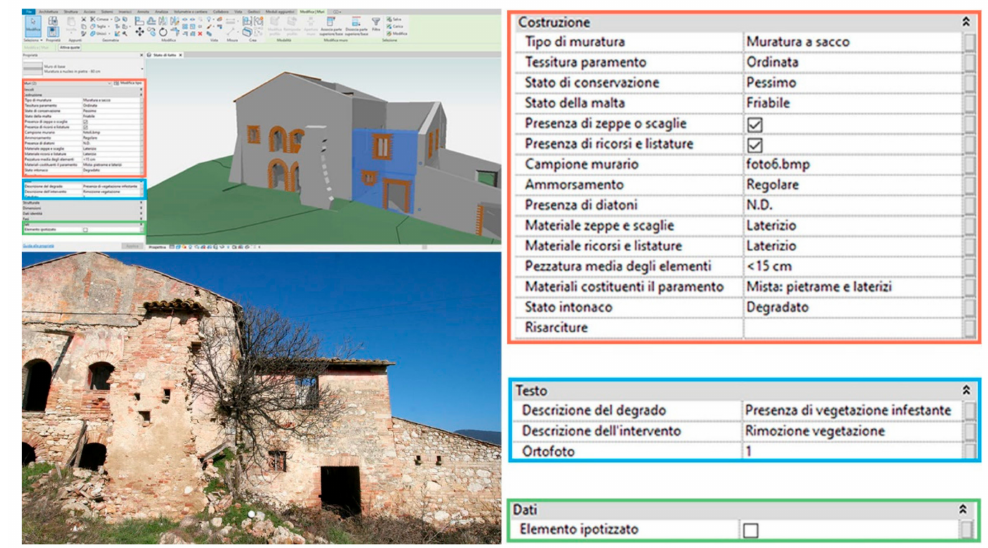
Figure 8. Visualization in the continuous model of a building element and its properties. Through the creation of textual parameters linked to the information with VPL, it is possible to characterize the three-dimensional elements both in terms of the actual state and with design responses to the declaration of decay. Furthermore, through on/off parameters, it is possible to declare the real or hypothetical nature of the element itself (see Figure